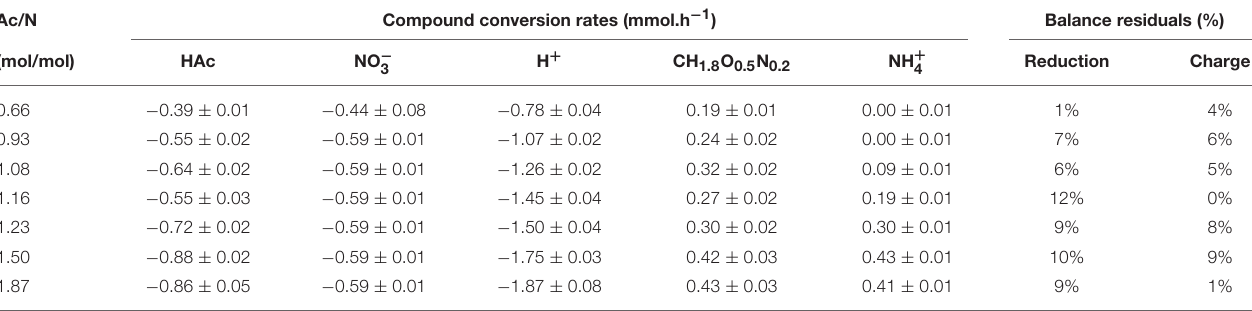
TABLE 4 | Steady state conversion rates and balances for the enrichment cultures at different Ac/N ratios. Ac/N